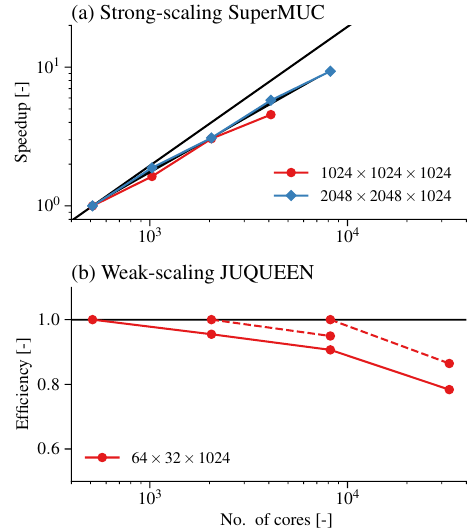
Figure 12. Speedup from a strong-scaling experiment (a) . Effi- ciency from a weak-scaling experiments (b) . Black lines indicate perfect speedup and efficiency. The dashed red lines show the effi- ciency change relative to the previous measurement.